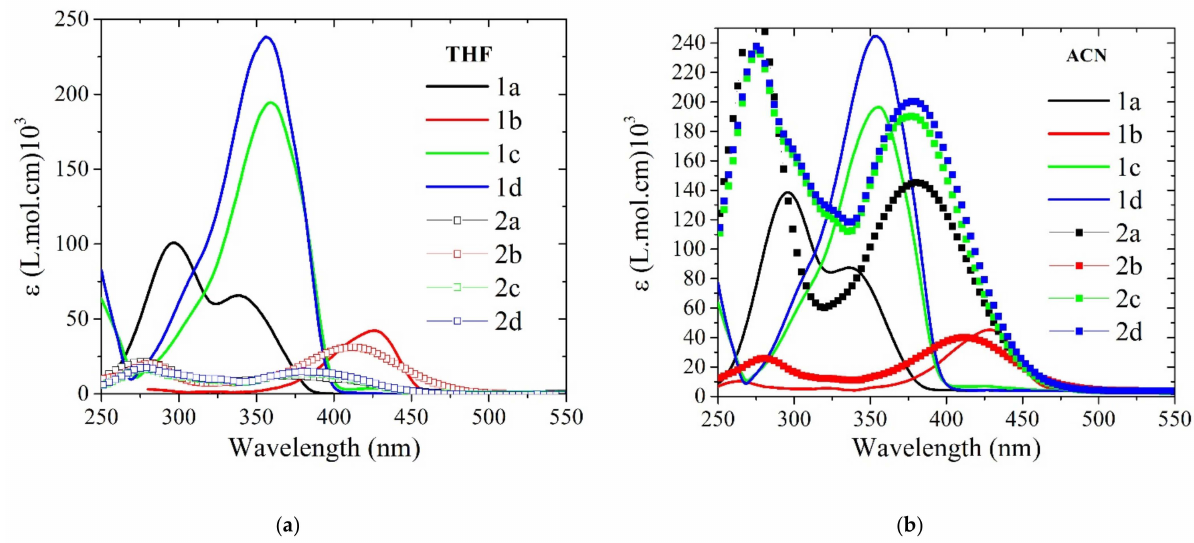
Figure 1. Absorption UV-vis spectra of compounds 1a – d and 2a – d ( c = 1 × 10 − 4 M, at 25 ◦ C) in ( a ) THF, and ( b ) acetonitrile.